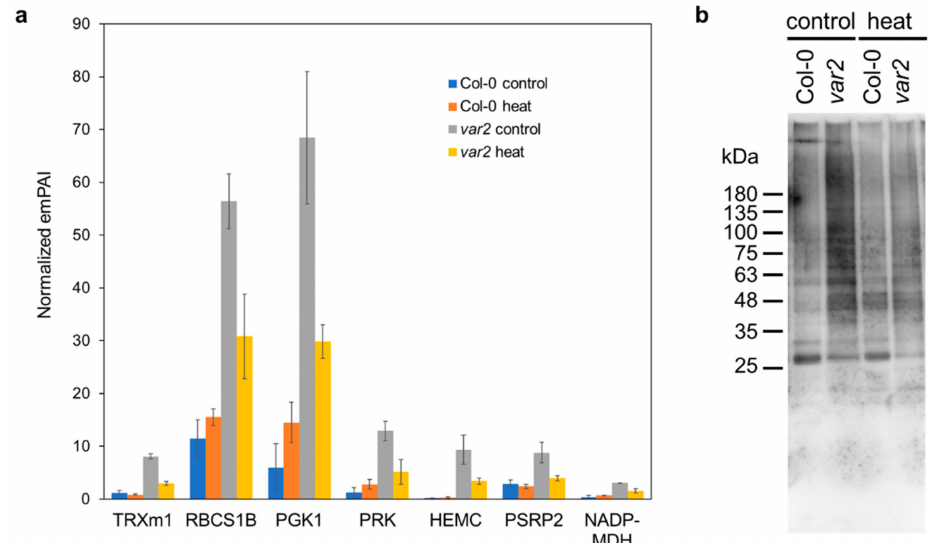
Figure 3. Oxidative stress-dependent protein accumulation in var2. ( a ) Stromal proteins affected by the FtsH defect. Protein abundances were shown as emPAI-based normalized quantitative values (the mean of the two replicates +/ − SD). For details, refer to Table S1. ( b ) Immunoblot analysis showing carbonylated proteins accumulating in the var2 mutant under normal conditions rather than stress conditions. The carbonylated proteins were chemically modified with 2,4-dinitrophenylhydrazine (DNPH) and detected using anti-DNP antibody. Each lane contains 3 µ g of protein extracts from the thylakoid